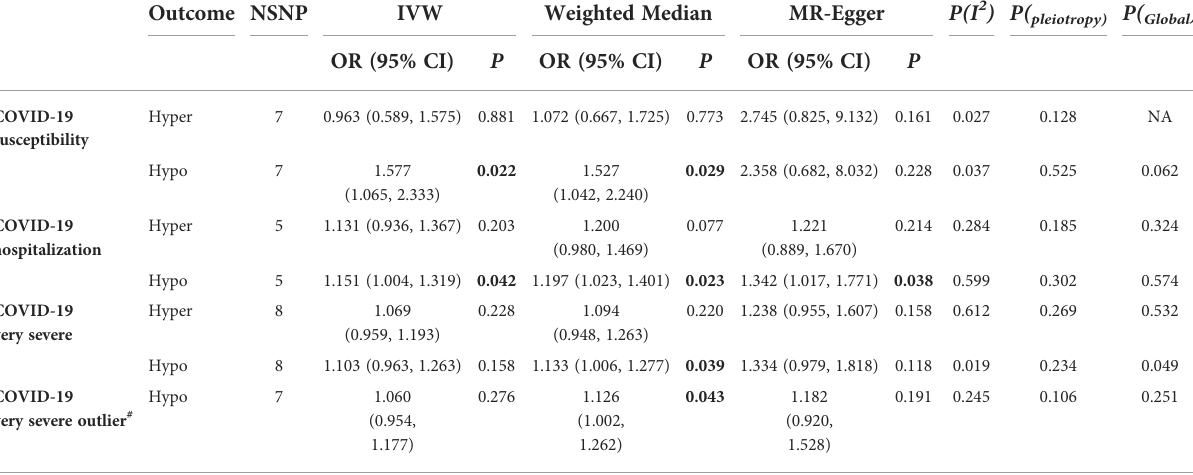
TABLE 3 MR estimates for the causal effect of COVID-19 on thyroid dysfunction.